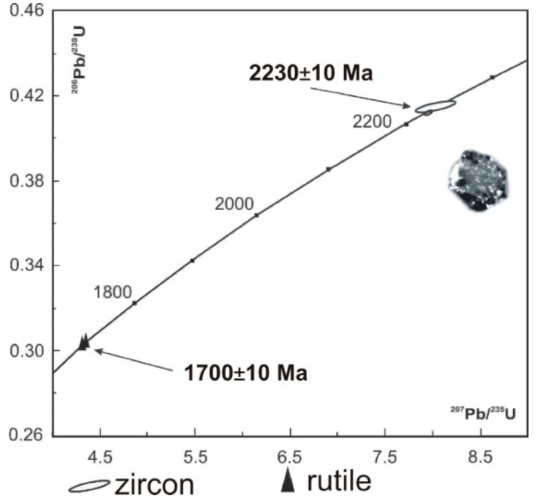
Figure 7. Isotope U–Pb plots for single zircon grains and rutile from anorthosites, Kandalaksha (sample 225 / 1)